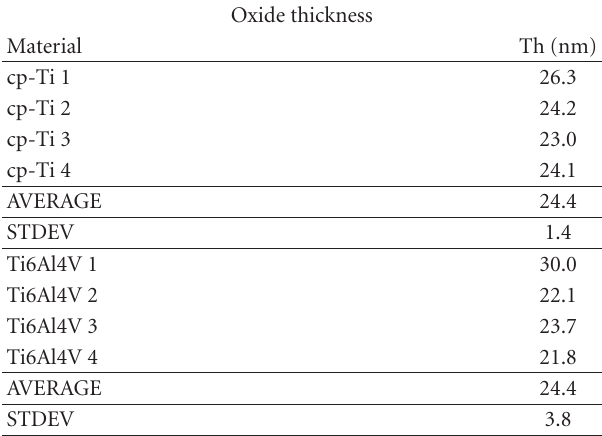
Table 1: The calculated oxide thicknesses for the cp-Ti and Ti6Al4V sca ff olds, showing the mean value and standard